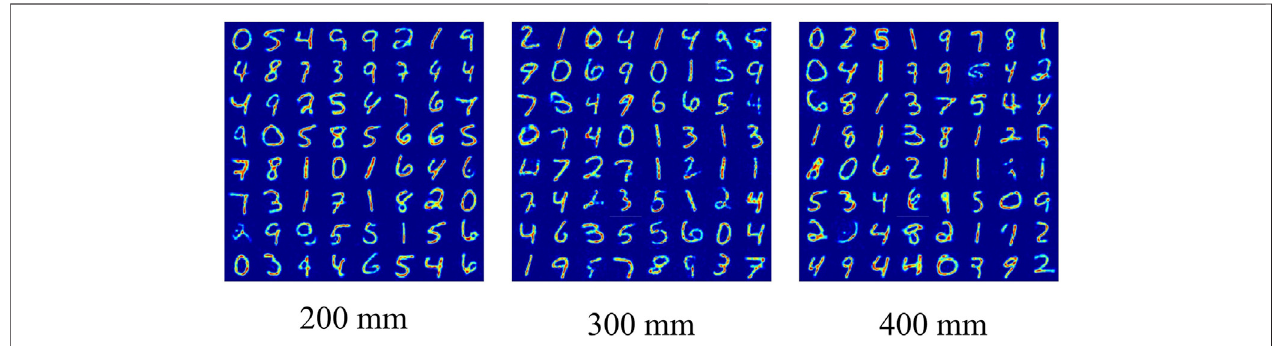
FIGURE 4 | Imaging results of hologram obtained via numerical simulation based on generator inputs of d = 200, 300, and 400 mm.